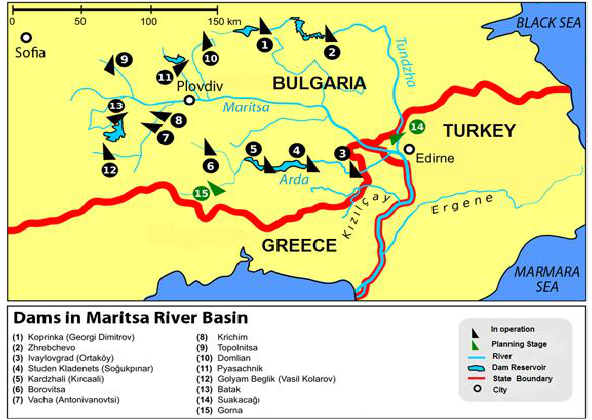
Figure 1. Trans-boundary Maritsa river basin and reservoirs (Yildiz,